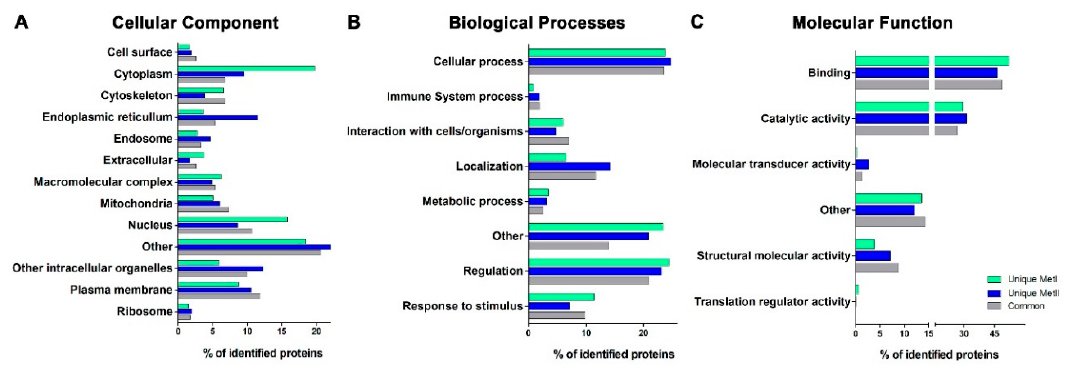
Figure 6. Analysis of unique and common proteins localized in mast cell lipid rafts isolated with MetI or MetII. The unique and common proteins identified using MetI and MetII in lipid rafts from RBL-2H3 MCs were analyzed according to the three main GO classes: ( A ) cellular component, ( B ) biological processes, and ( C ) molecular function. Data for the unique and common proteins identified using MetI and MetII in lipid rafts from RBL-2H3 MCs was annotated using STRAP. Table 2. Highest percentage of annotated proteins within each GO term.